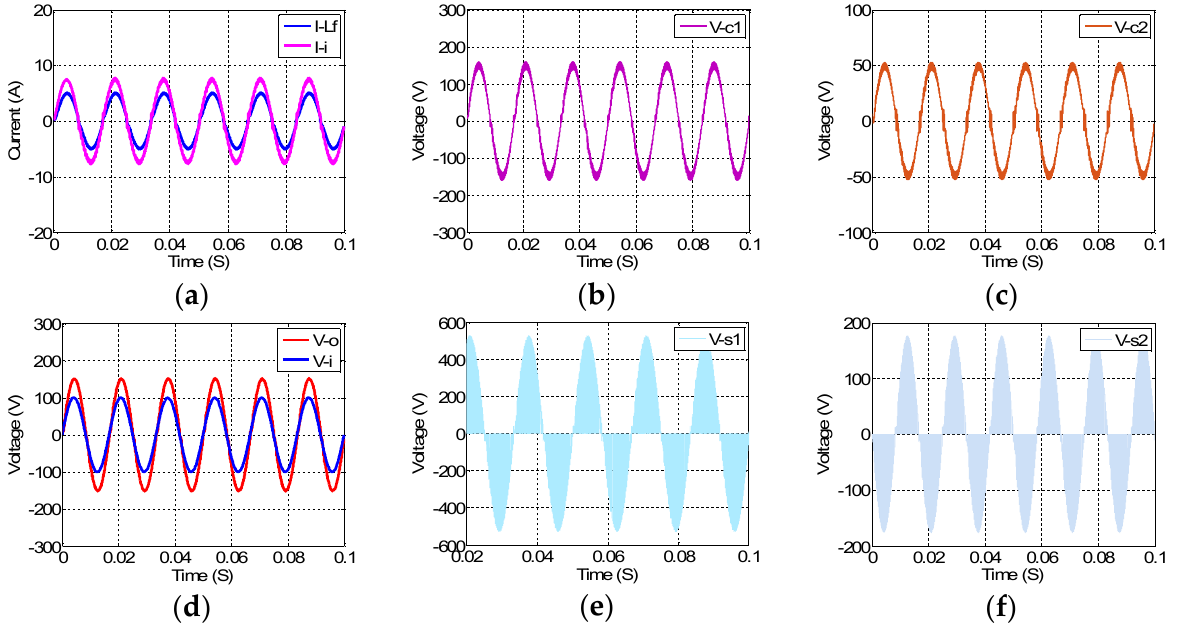
Figure 11. Simulation results of the boost in-phase mode with n = 1.5, R = 30 Ω, and D = 0.1. ( a ) output filter and input current; ( b ) Voltage across C 1 ; ( c ) voltage across C 2 ; ( d ) output and input voltages; ( e ) voltage across S 1 ; ( f ) voltage across S 2.